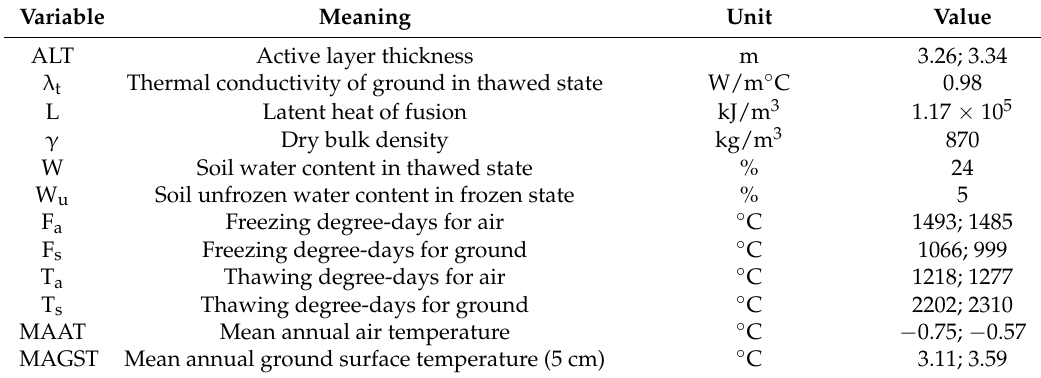
Table 1. Climate and environmental variables for the KMP and the slope. The values comprise the parameters in 2014 followed by those in